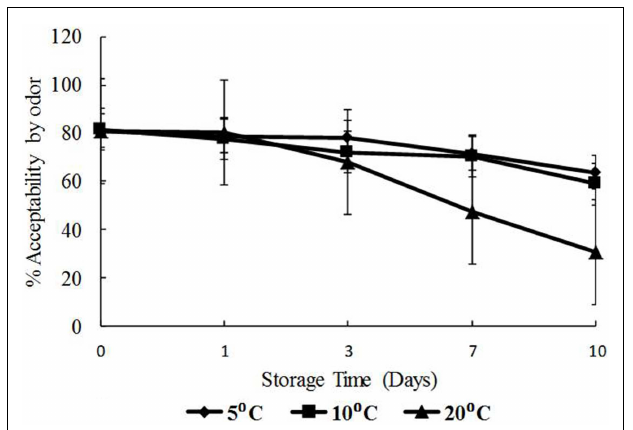
FIGURE 8 | Changes in area versus storage time (days) and temperature (5, 10, and 20°C)